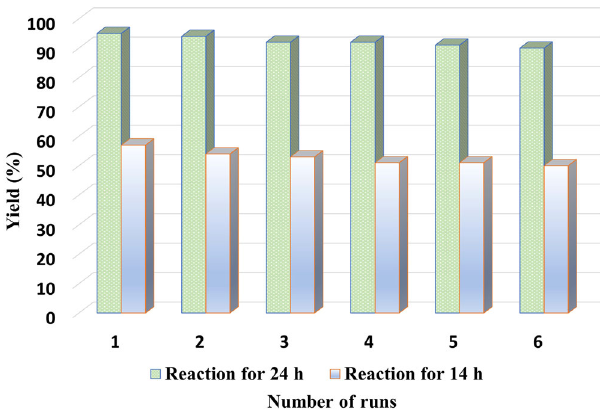
Fig. 8 Recyclability of Fe 1 -N-C for the synthesis of benzonitrile.